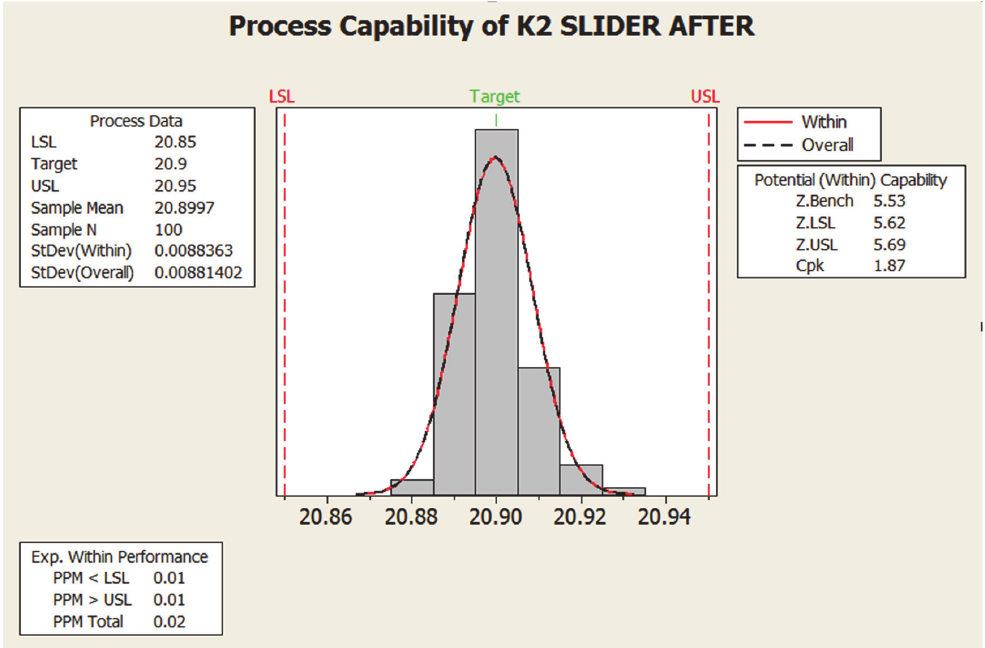
Fig. 10. Process Capability of Lock Nut Slider after Implementing